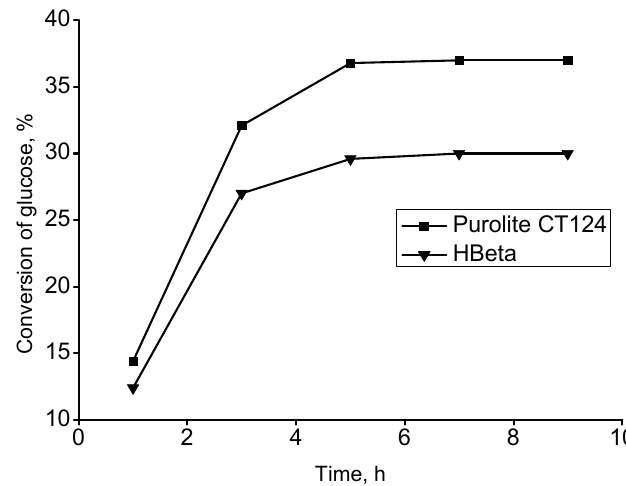
Figure 8. Conversion of glucose as a function of the synthesis time over Purolite CT124 and zeolite H-Beta at 100